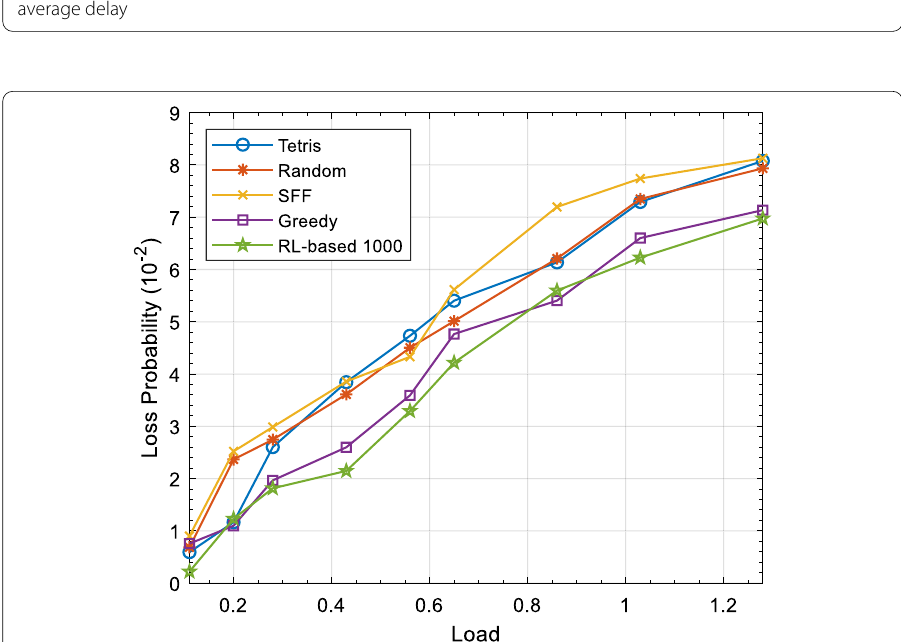
Fig. 10 Loss probability with D MAX = 3 ms . The loss probabilities of the RL-based, Greedy, Random, SFF, and Tetris schemes with maximum delay constraint D MAX = 3 ms . The x -axis is the load, and the y -axis is the loss probability in Eq.